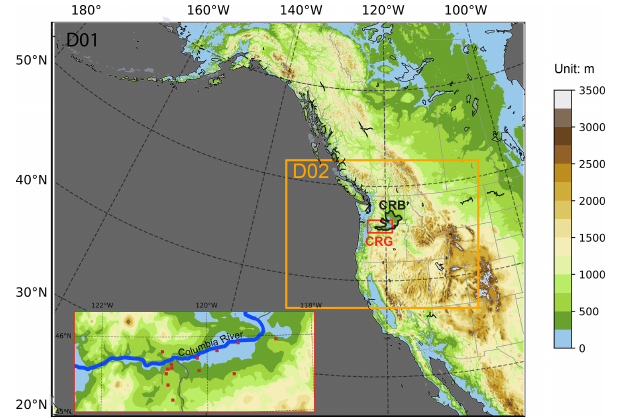
Figure 1. Model domain with terrain elevation indicated by colors. The Columbia River Gorge (CRG) and Columbia River Basin (CRB) are outlined in red and black, respectively. The insert axes amplify the CRG with WFIP2 sodar and lidar